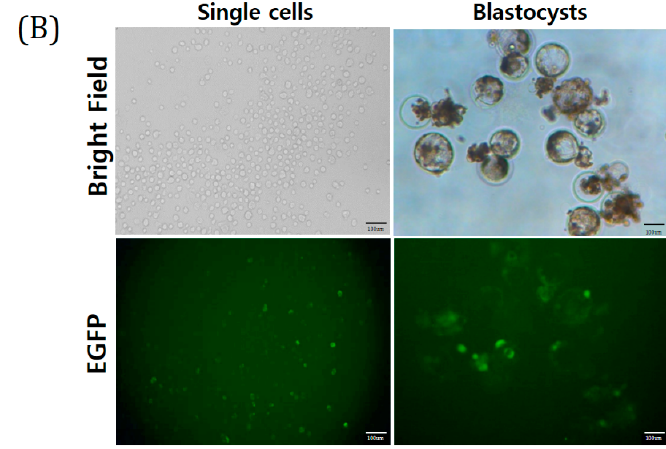
Figure 1. Evaluation of ( A ) cleavage and the blastocyst formation rate of embryos produced through somatic cell nuclear transfer (SCNT). The cleavage rate was measured on day 2, and blastocyst formation rate was evaluated on day 7 of culture. ( B ) Expression of enhanced green fluorescent protein (EGFP) in TG donor cell and SCNT BLs. Scale bars 100 µm.